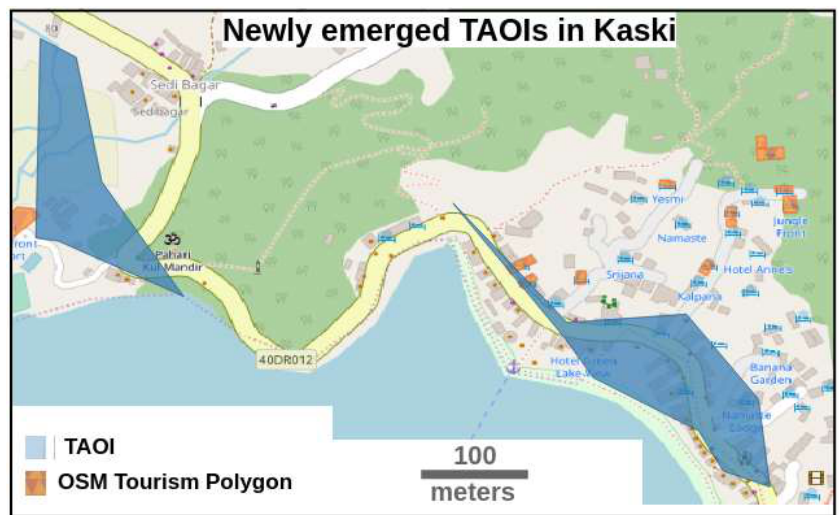
Figure 8. New TAOI that Appears in Kaski (Source: Devkota et al.,